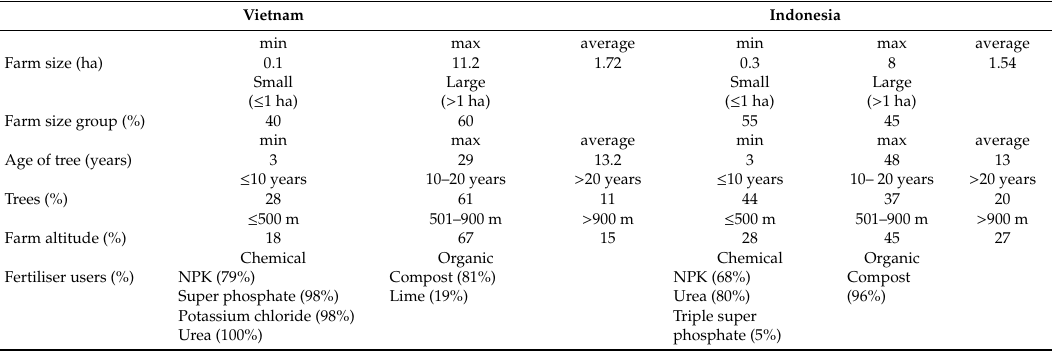
Table 2. Characteristics of co ff ee farms surveyed during the 2008–2017 period in selected provinces in Vietnam and Indonesia. The total number of monitored farms per year was 558 in Vietnam and 240 in Indonesia.